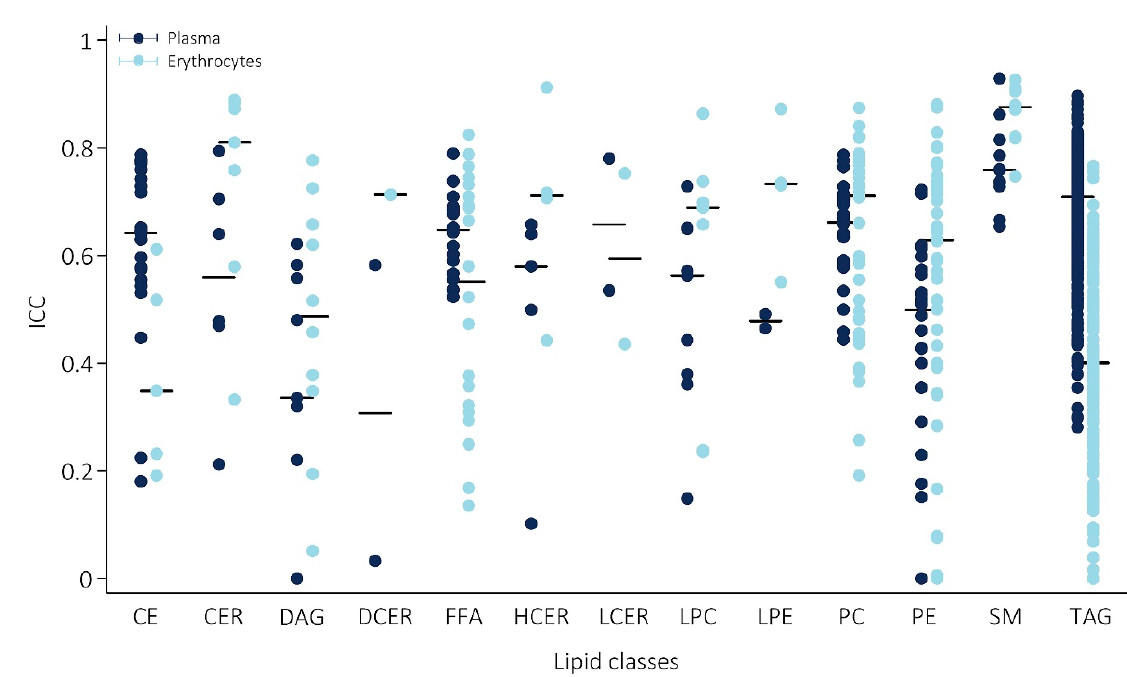
Figure 3. Reproducibility of the lipids over a 6-week period, stratified by lipid class. Reproducibility of individual lipids within each class in plasma (blue) and erythrocytes (red); bars represent the median intraclass correlation coefficient (ICC) of the lipid class. Abbreviations: ICC = intraclass correlation coefficient, CE = cholesteryl ester, CER = ceramide, DAG = diacylglycerol, DCER = dihydroceramide, FFA = free fatty acid, HCER = hexosylceramide, LCER = lactosylceramide, (L)PC = (lyso)phosphatidylcholines, (L)PE = (lyso)phosphatidylethanolamine, SM = sphingomyelin, TAG = triacylglycerol.